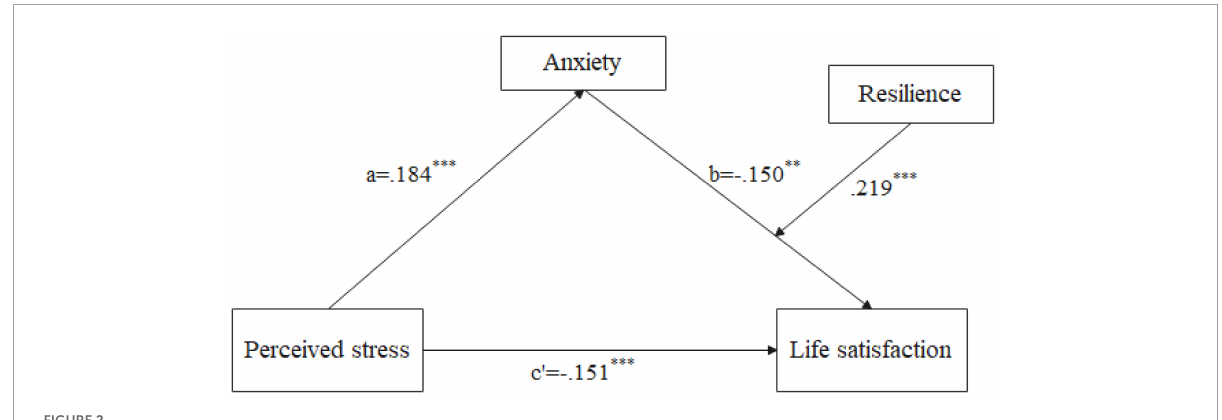
FIGURE2 The final moderated mediation model ( ∗∗ p < 0.01; ∗∗∗ p <